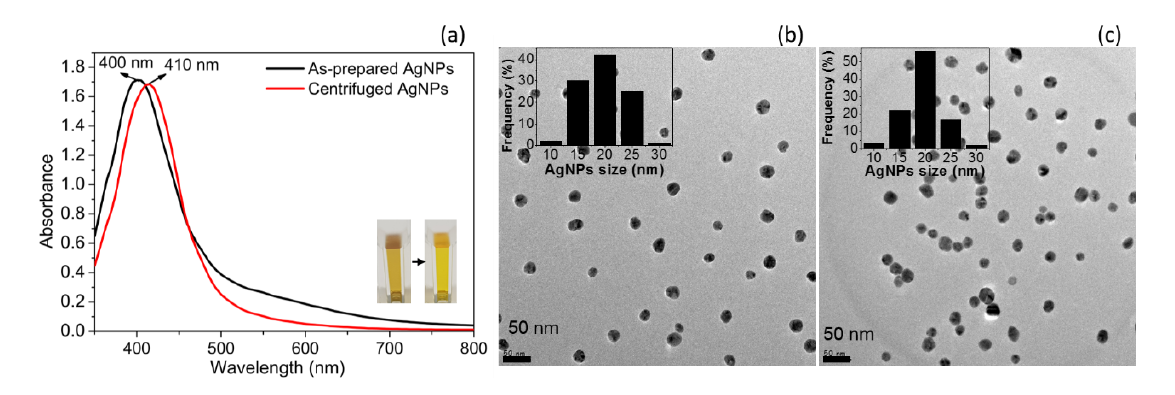
Figure 1: (a) UV–vis spectrum and color of silver nanoparticles before and after centrifugation. A representative HR-TEM image of silver nanoparti- cles (b) before and (c) after